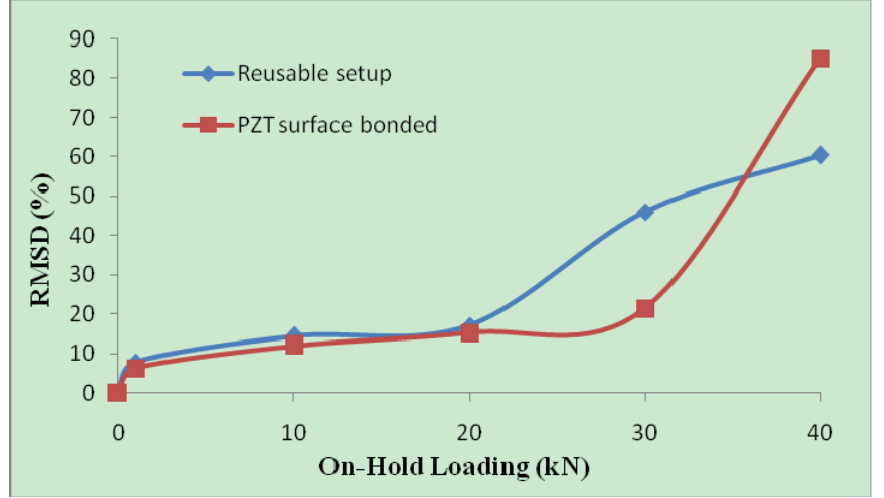
Figure 14. Comparison of RMSD values for reusable PZT setup and surface bonded